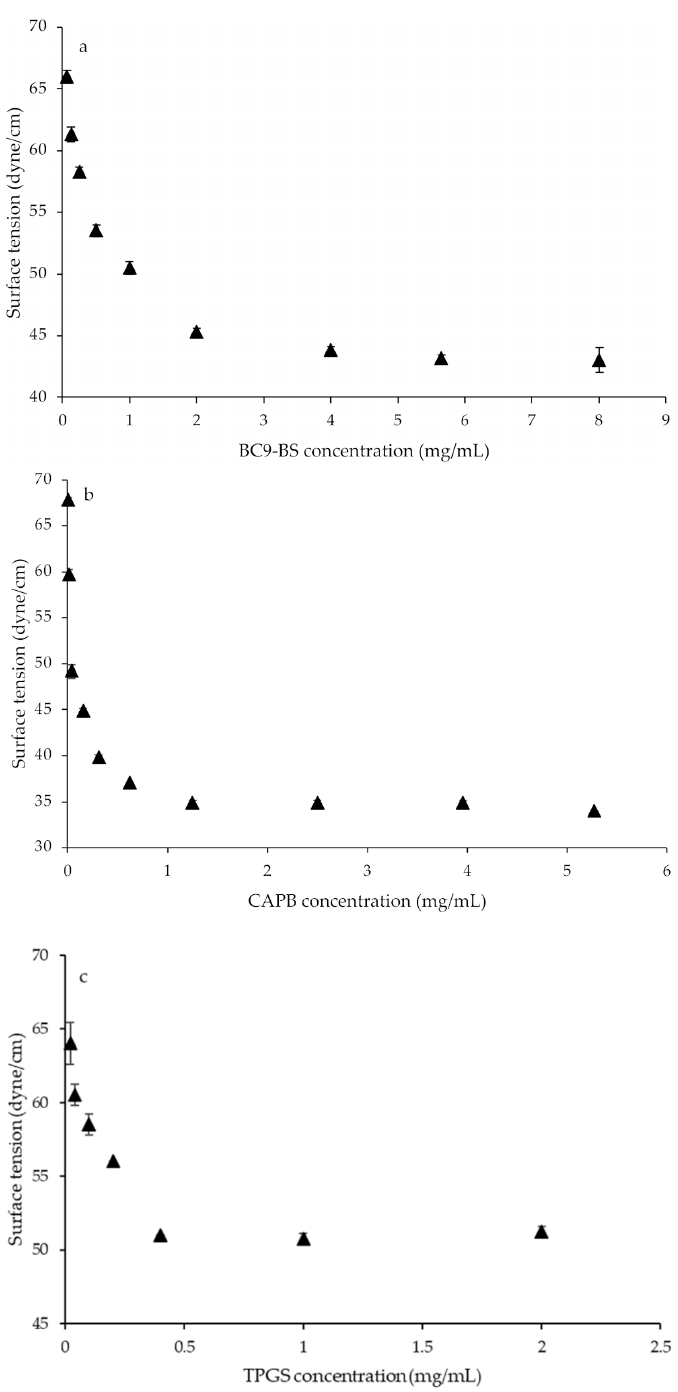
Figure 1. Surface tension values as function of ( a ) biosurfactant from L. gasseri BC9 (BC9-BS), ( b ) Cocamidopropyl betaine (CAPB) and ( c ) D- α -tocopheryl polyethylene glycol 1000 succinate (TPGS) concentrations (mg/mL). Data are plotted as mean values of surface tension (dyne/cm) ± SD ( n =